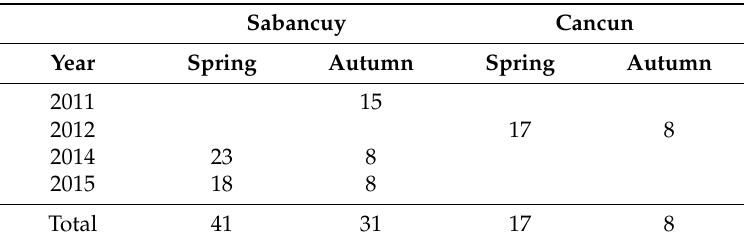
Table 2. Number of nights used for analysis by radar, season, and year.